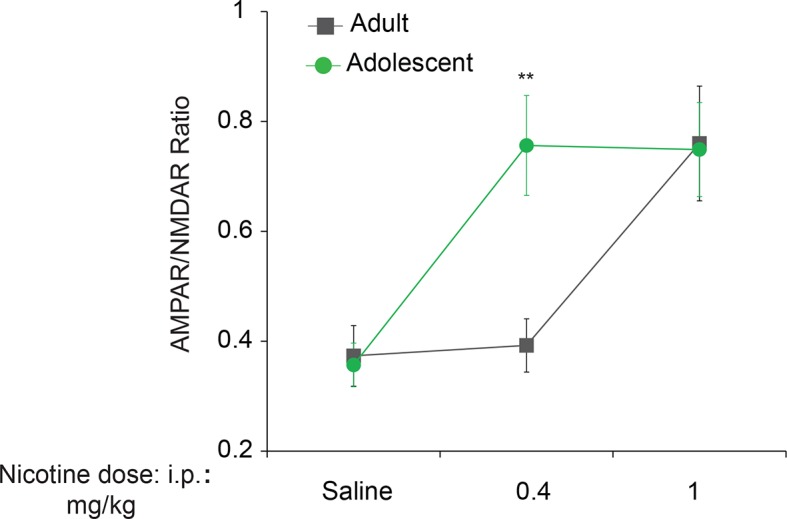
Adolescent mice are more susceptible than adult mice to nicotine-induced synaptic potentiation.Adolescent (5 weeks old, n=6–7 per group) or adult mice (3–5 months old, n=6–7 per group) were i.p-injected with saline or nicotine at indicated doses and whole-cell recordings were performed in VTA DA neurons. An increase in the AMPAR/NMDAR ratio (an index of LTP) was induced with the 0.4 mg/kg dose of nicotine (F2,32=4.34, P<0.01 vs. saline) in adolescent mice, whereas 1.0 mg/kg was required for a significant increase in adults (F2,32=4.34, P<0.05 vs. saline or 0.4 mg/kg nicotine).